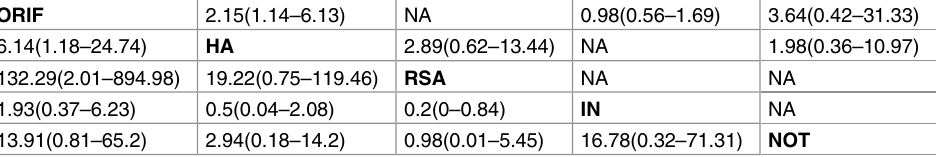
Fig 7. Network of treatment comparisons for incidence of additional surgery. The size of the node corresponds to the total sample size of treatments. Directly comparable treatments are linked with a line, the thickness of which represents the numberof trials that were compared. ORIF: open reduction and internalfixation; HA: hemiarthroplasty; RSA: reverse shoulderarthroplasty; IN: intramedullary nailing;NOT: Non-operative treatment. doi:10.1371/journal.pone.0166801.g007 Table 5. Results for incidence of additional surgery, from network meta-analysis (lower diagonal part) and pairwise meta-analysis (upper diagonal